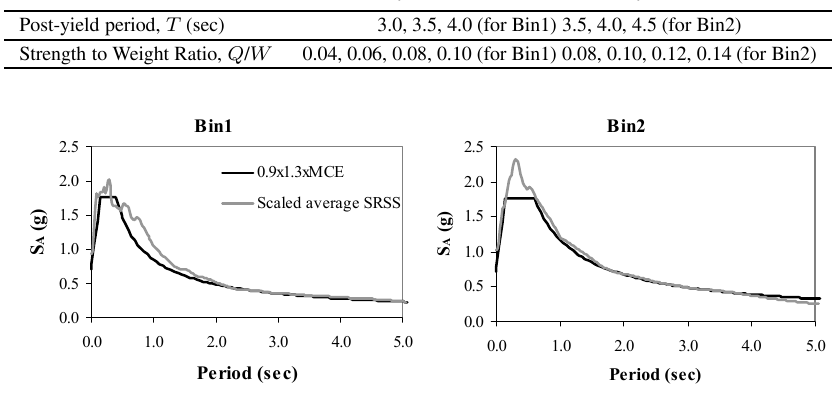
Table 4 Parameters for isolation systems considered in this study